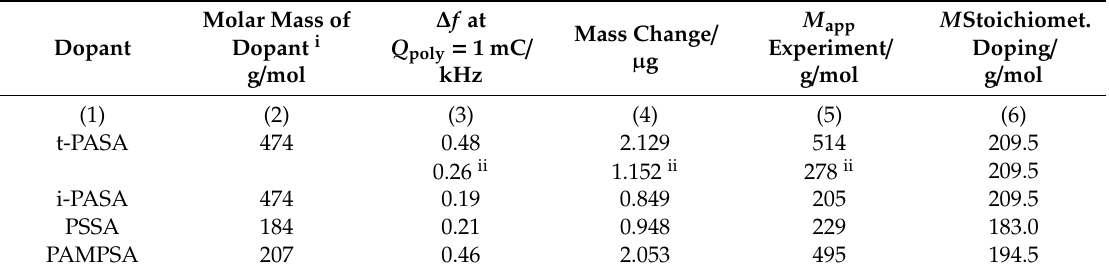
Table 1. Apparent molar mass of the species deposited in the course of